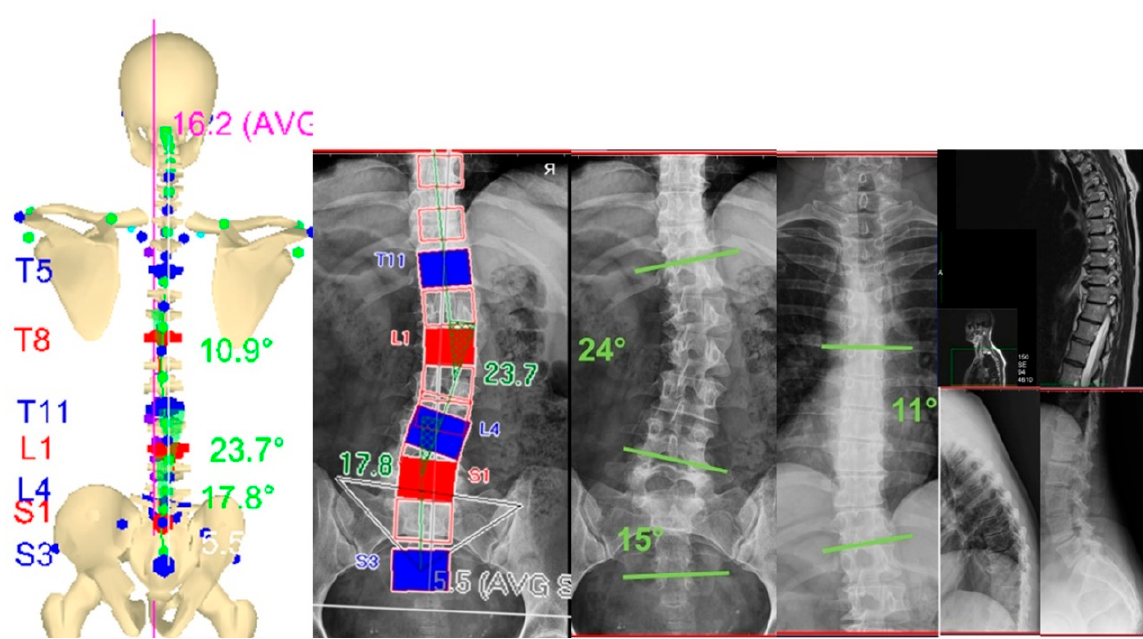
Figure 3. Comparison between stereo-photogrammetric 3D spine reconstruction and X-ray spine deformities measurement in the frontal plane. On the right side, X-ray and MRI evaluations document degenerative changes in both the vertebrae (arthrosis) and intervertebral discs, compression to the radicular nerves with osteophytes/bone spurs at the various level either at the lumbar or thoracic spine.